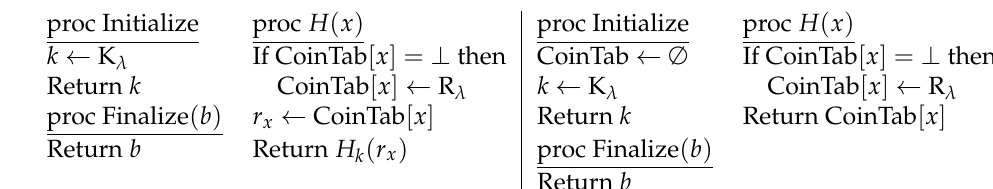
Figure 3. Games defining security for a strong randomness extractor H . Game REAL is on the left while Game RAND is on the